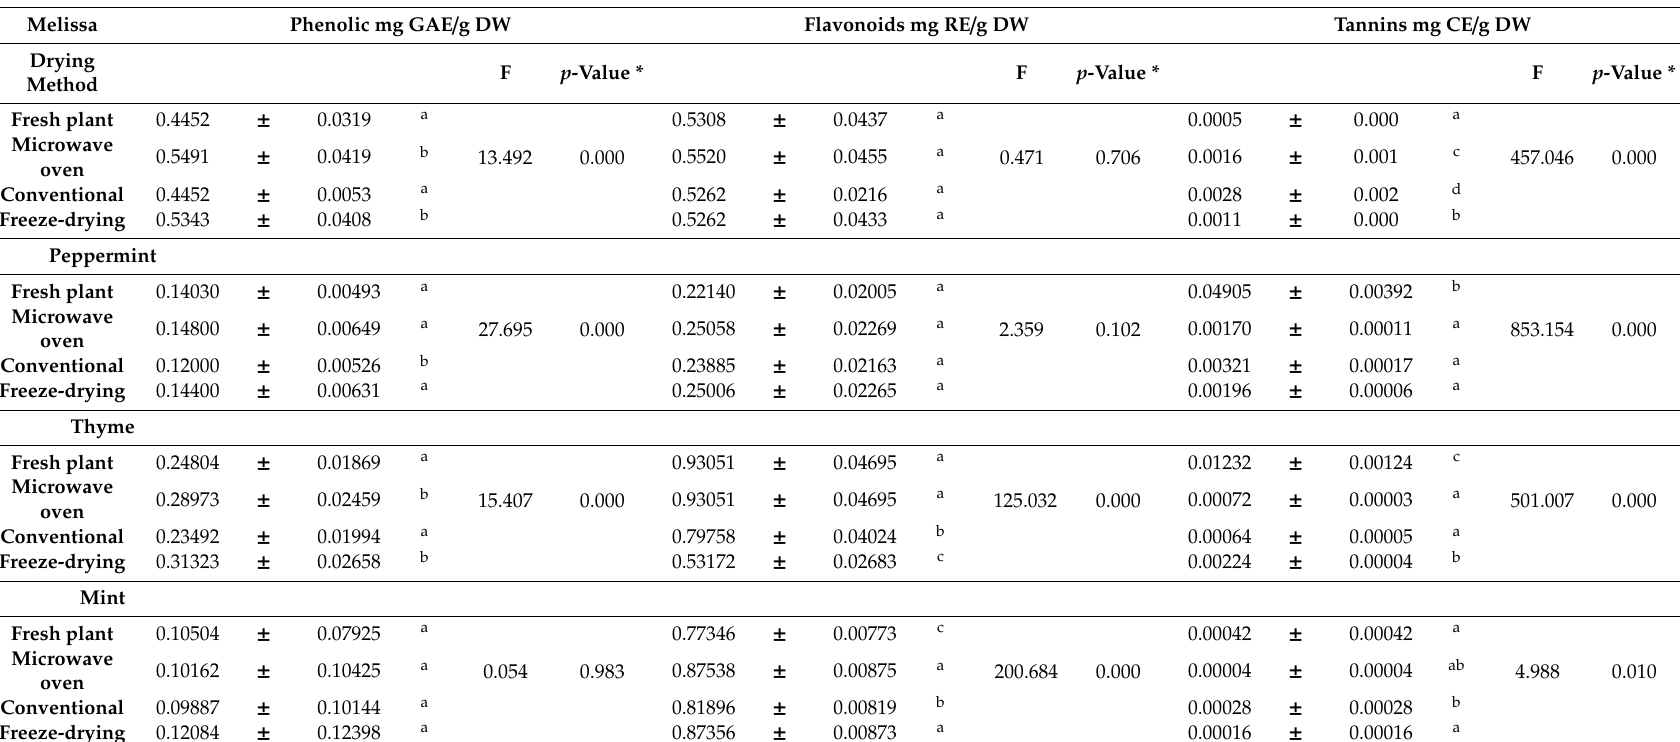
Table 1. Phenolic compounds content in methanol extracts in Melissa, peppermint, thyme, and mint.